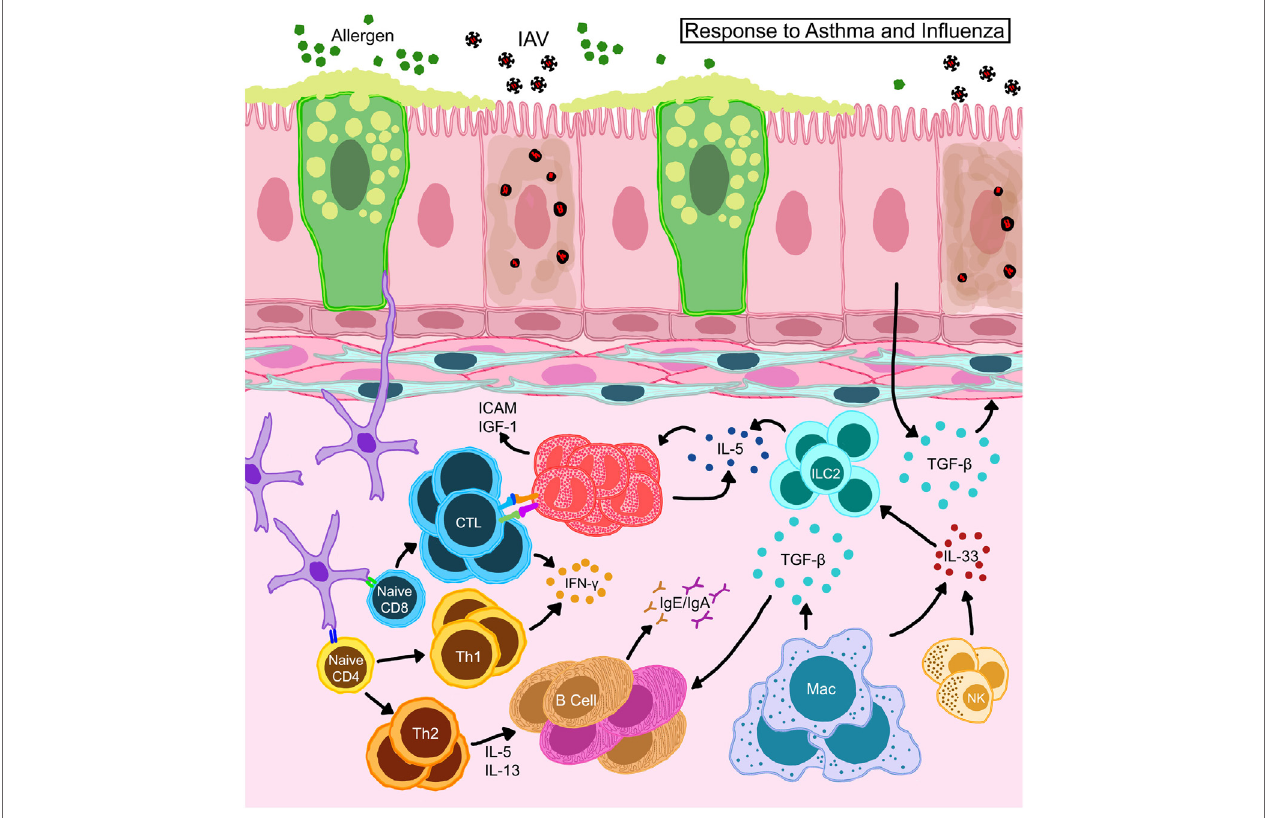
FiGURe 5 | Schematic representation of immune responses in allergic hosts during influenza A virus infection. Bronchial epithelia in allergic hosts upregulate intracellular adhesion molecule (ICAM-1) and insulin-like growth factor (IGF-1) to recruit/activate immune mediators. Alveolar macrophages and natural killer (NK) cells release large amounts of IL-33 and trigger innate lymphoid cells (ILCs) to release IL-5 thereby induce eosinophil accumulation and survival in situ . Eosinophils engage in the activation of CD8 + T cells in the draining lymph nodes as well as on site to help enhance antiviral cellular immunity in the allergic host. Locally derived transforming growth factor (TGF)- β inhibits virus-induced pathology and may promote in situ IgA production. Interferons (IFN) released by T cells are important to heighten the “antiviral” state in the microenvironment to safeguard structural and immune cells from virus-induced